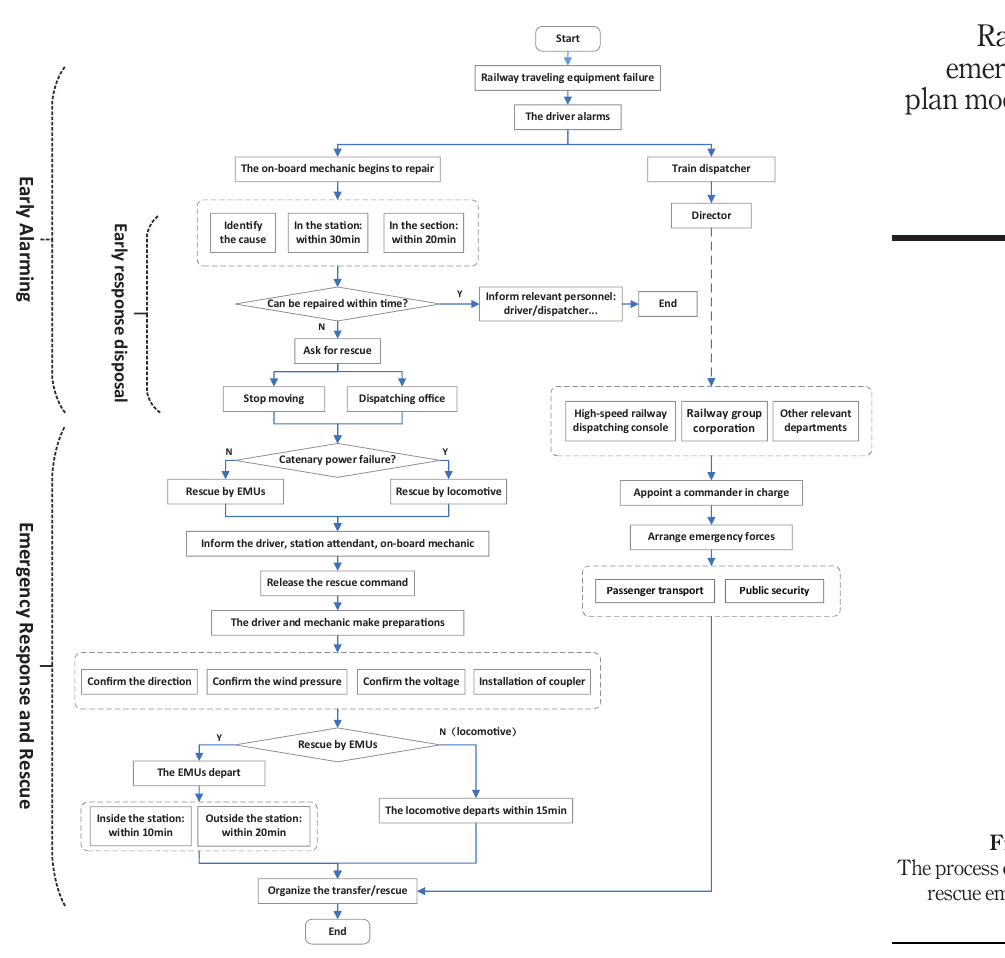
Figure 5. The process of EMUs rescue emergency